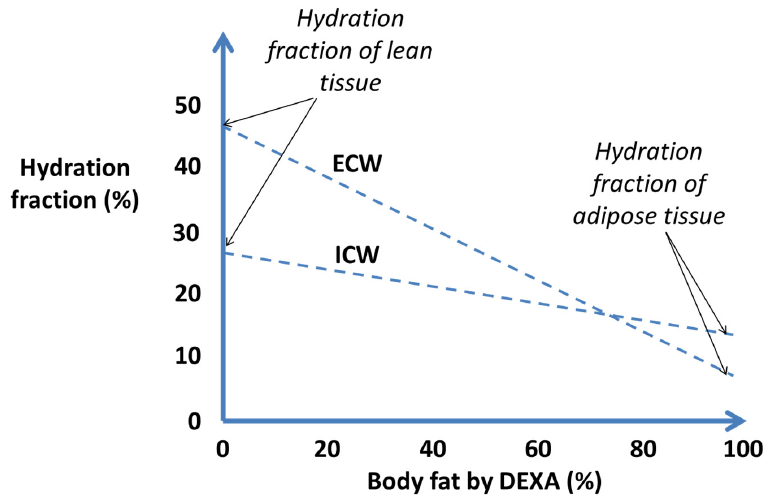
Figure A1. Estimation of the fractional hydration of ECF and ICF in lean and adipose tissue, by extrapolation of regression lines based on dilution based fluid volumes and DEXA body fat. Reproduced from